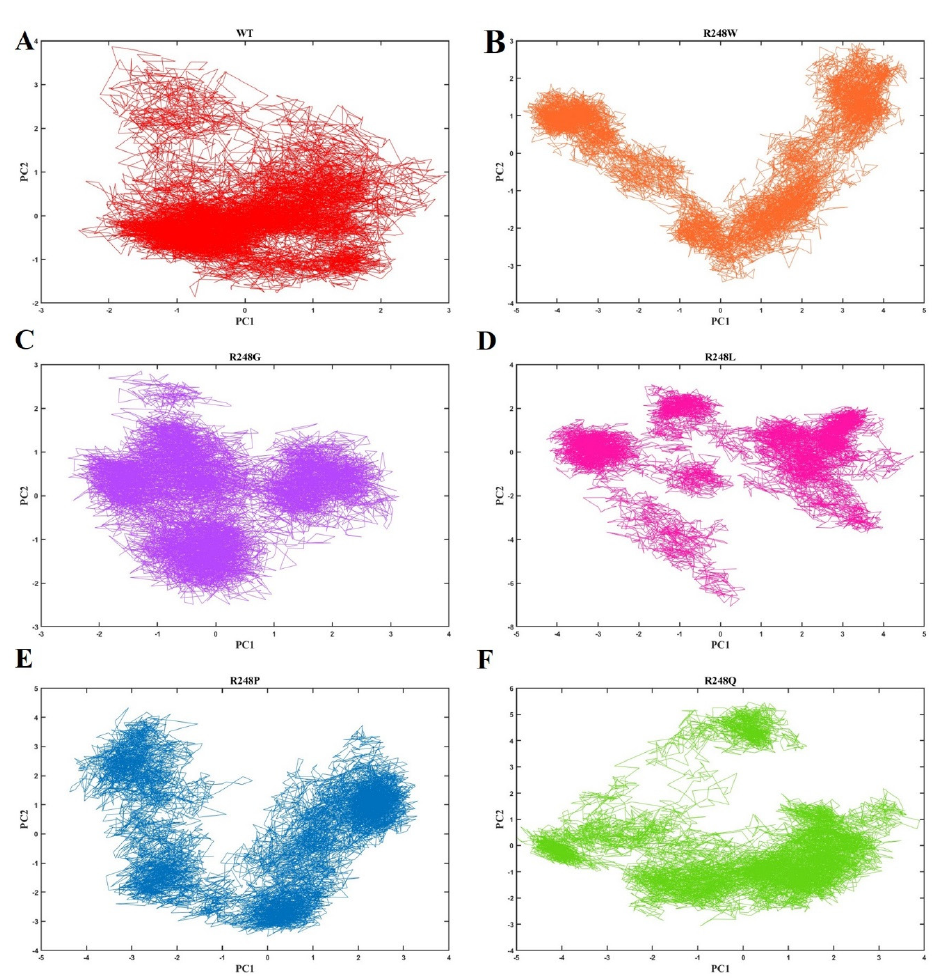
Figure 8. The principal component analysis (PCA) of the wt-p53–DNA complex and R248 mutant- p53–DNA complexes. ( A ) The red color represents the wt-p53–DNA complex, ( B ) the orange color represents the R248W mutant-p53–DNA complex, ( C ) the violet color represents the R248G mutant- p53–DNA complex, ( D ) the pink color represents the R248L mutant-p53–DNA complex, ( E ) the blue color represents the R248P mutant-p53–DNA complex, and ( F ) the green color represents the R248Q mutant-p53–DNA complex.